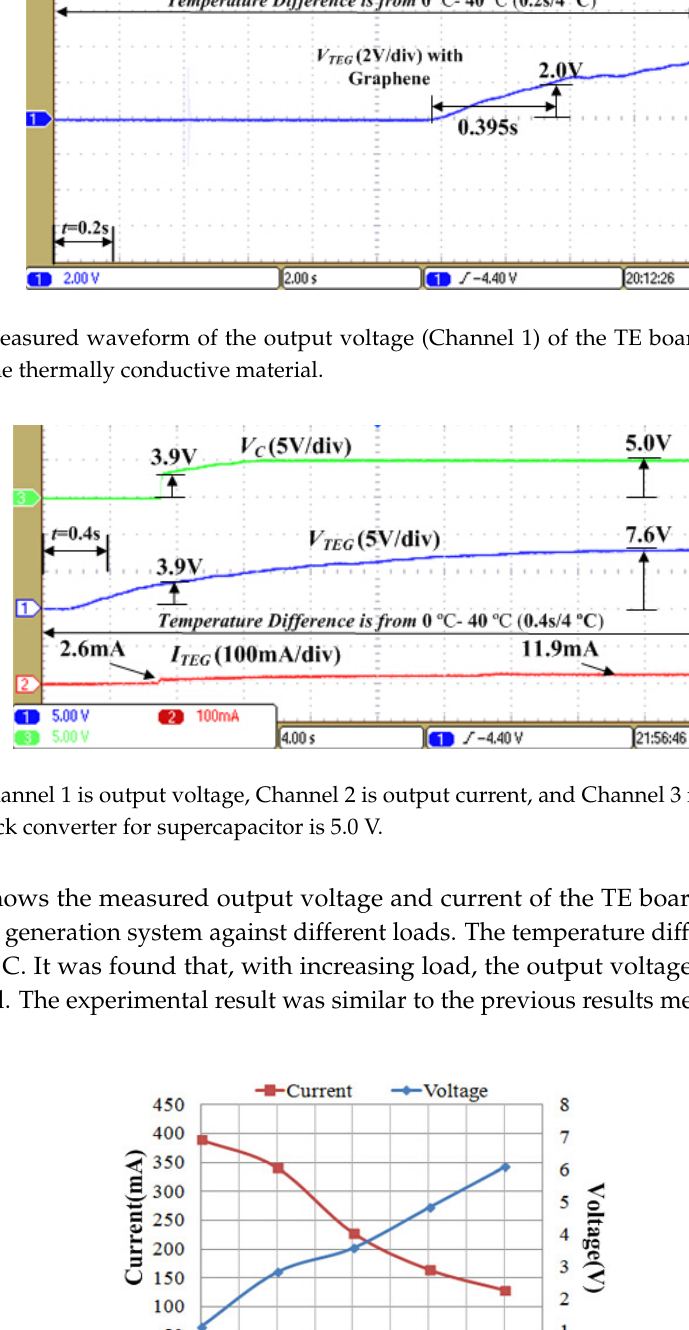
Figure 15. The output voltage and current of TE board with graphene in different loads.